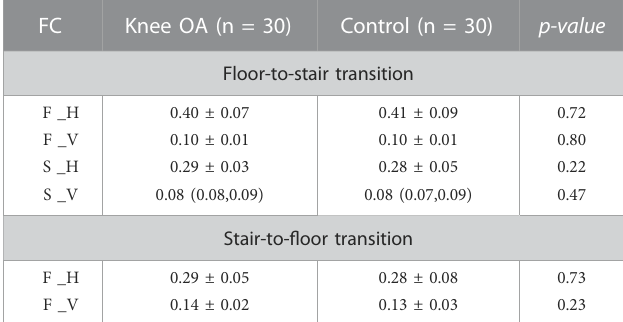
TABLE 3 Minimum foot-tread